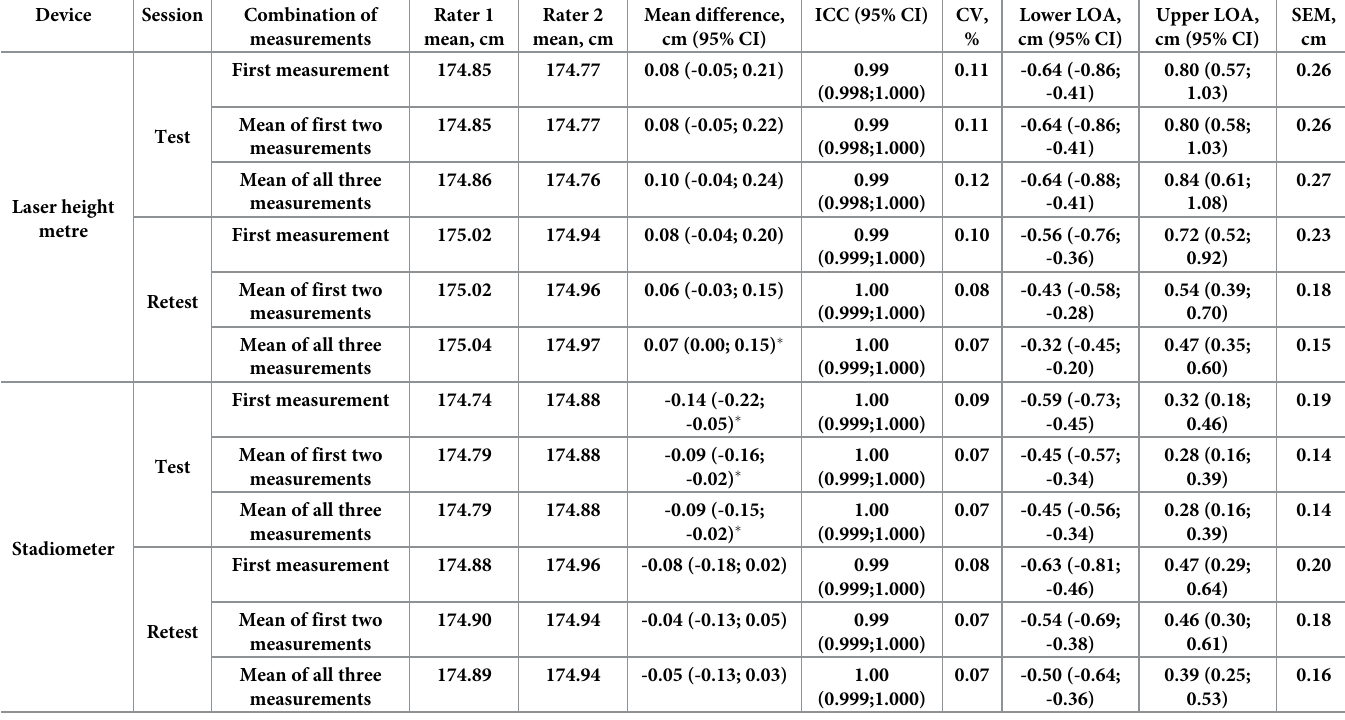
Table 2. Interrater reliability for height measurements on each test session with the laser height metre and stadiometer (n = 32).